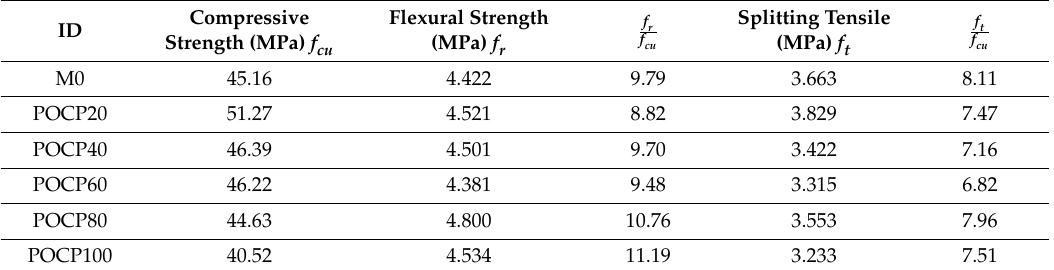
Table 5. Flexure, splitting and compressive strength relationship at 28 days.